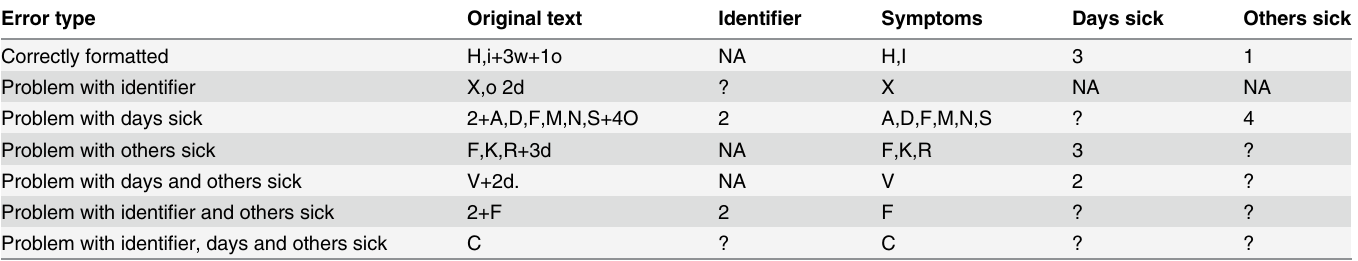
Table 2. Examples of syntax errors in text message reports, where ‘ ? ’ indicates a missing report element, and ‘ NA ’ an unneeded report element. Note ‘ problem with identifier and days ’ not included, due to no examples of this